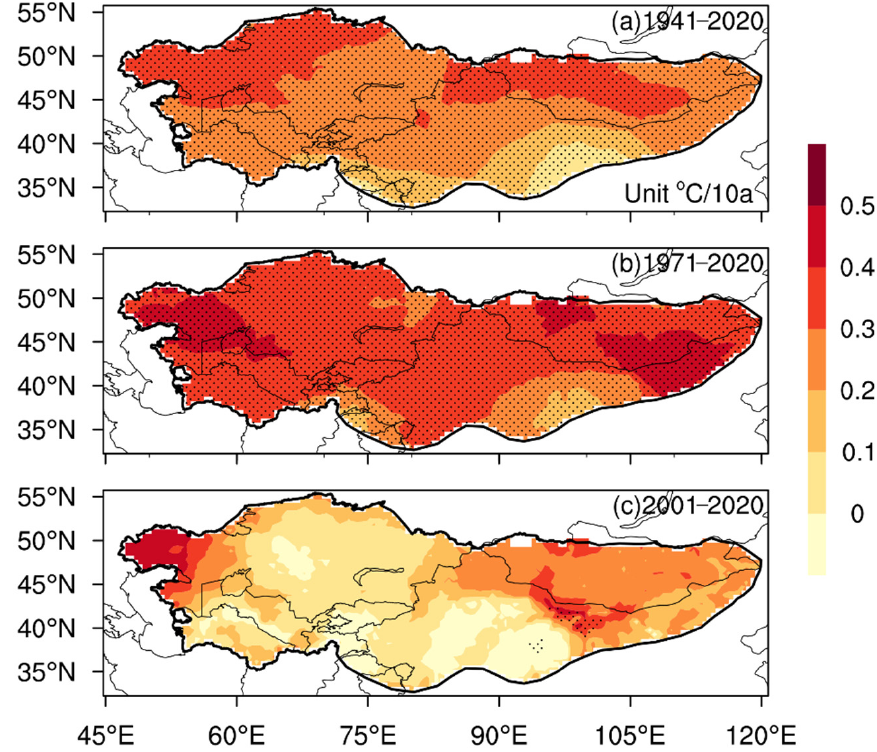
Figure 8. Same as Figure 7, but for variation rates (unit: °C/10a) of temperature ( a – c ).